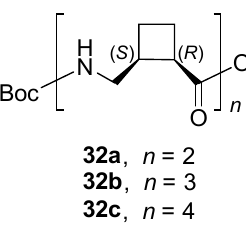
Figure 22. Chemical structure of short oligomers containing (1 R ,2 S )-2-(aminomethyl) cyclobuta- ne-1-carboxylic acid as its repetitive unit.